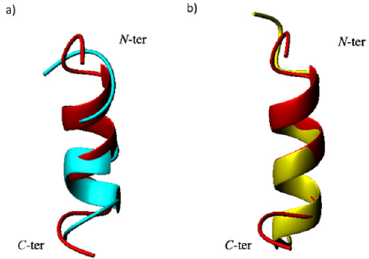
Figure 4. (a) Superposition of QK (red) and representative structure of D-QK (cyan) in aqueous solution (RMSD (N, Ca, C’(5–12) = 3.00 ± 1.5 Å) and ( b ) representative structure of D-QK in 30% TFE (RMSD (N, Ca, C’(5–12) = 0.46 ± 0.5 Å). The molecules are represented as ribbon.